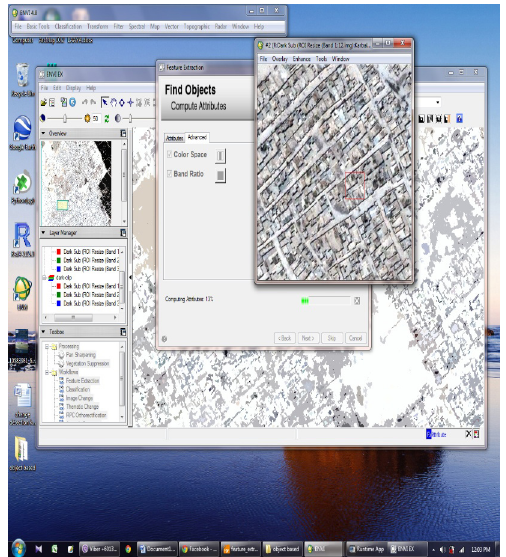
Figure 4. Image segmentation of the study area